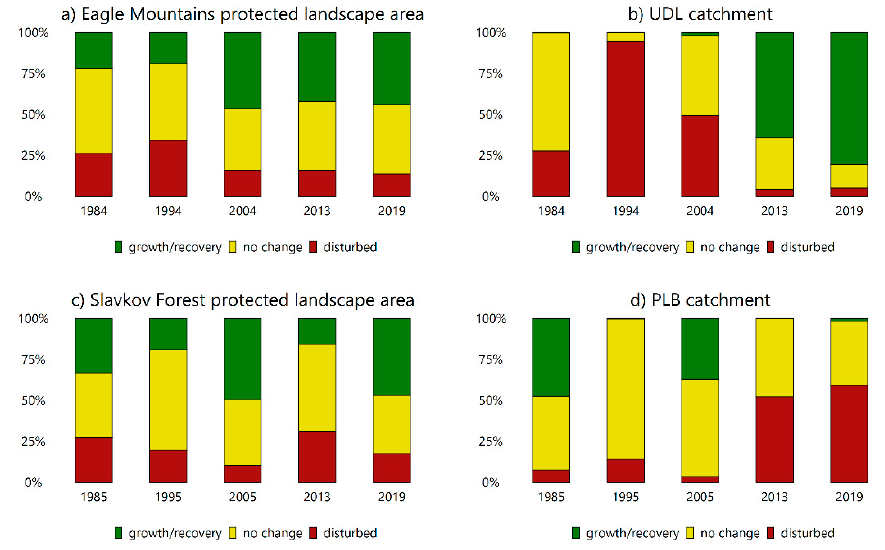
Figure 9. Percentages of disturbed (DI < µ − 0.5 σ ), no change (DI between µ − 0.5 σ and µ + 0.5 σ ), and growth / recovery (DI > µ + 0.5 σ ) pixels of ( a ) Eagle Mountains protected landscape area, ( b ) zoom to the UDL catchment, ( c ) Slavkov Forest protected landscape area, and ( d ) zoom to the PLB catchment. Statistics were computed from Figures 7 and 8.